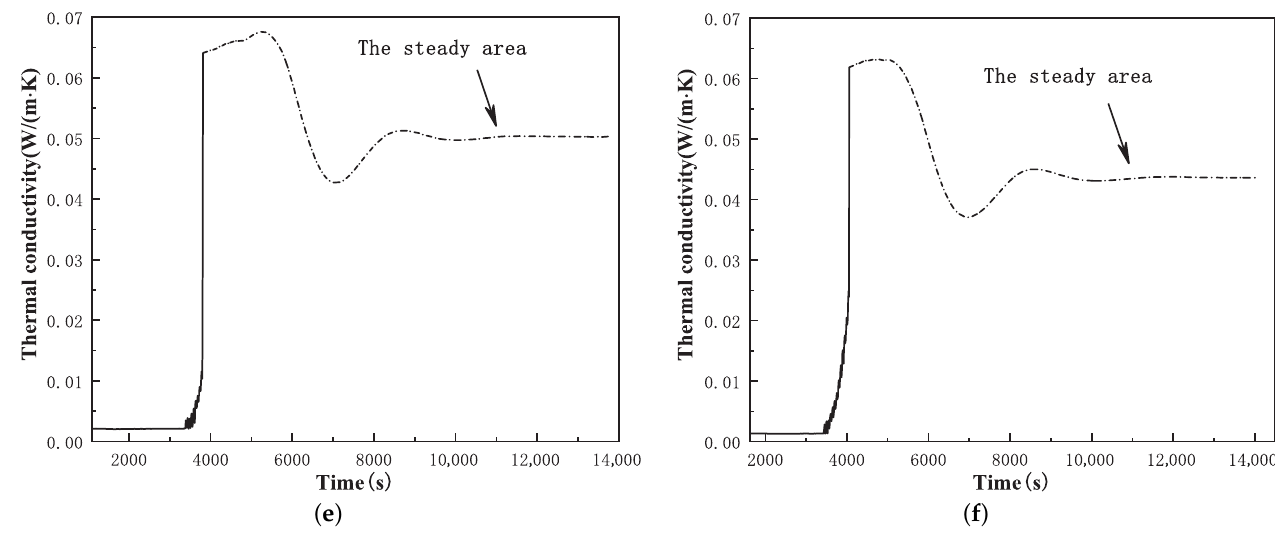
Figure 14. Test curve of thermal conductivity in the GCIB: ( a ) 1# insulation board; ( b ) 2# insulation board; ( c ) 3# insulation board; ( d ) 4# insulation board; ( e ) 5# insulation board; ( f ) 6# insulation board.